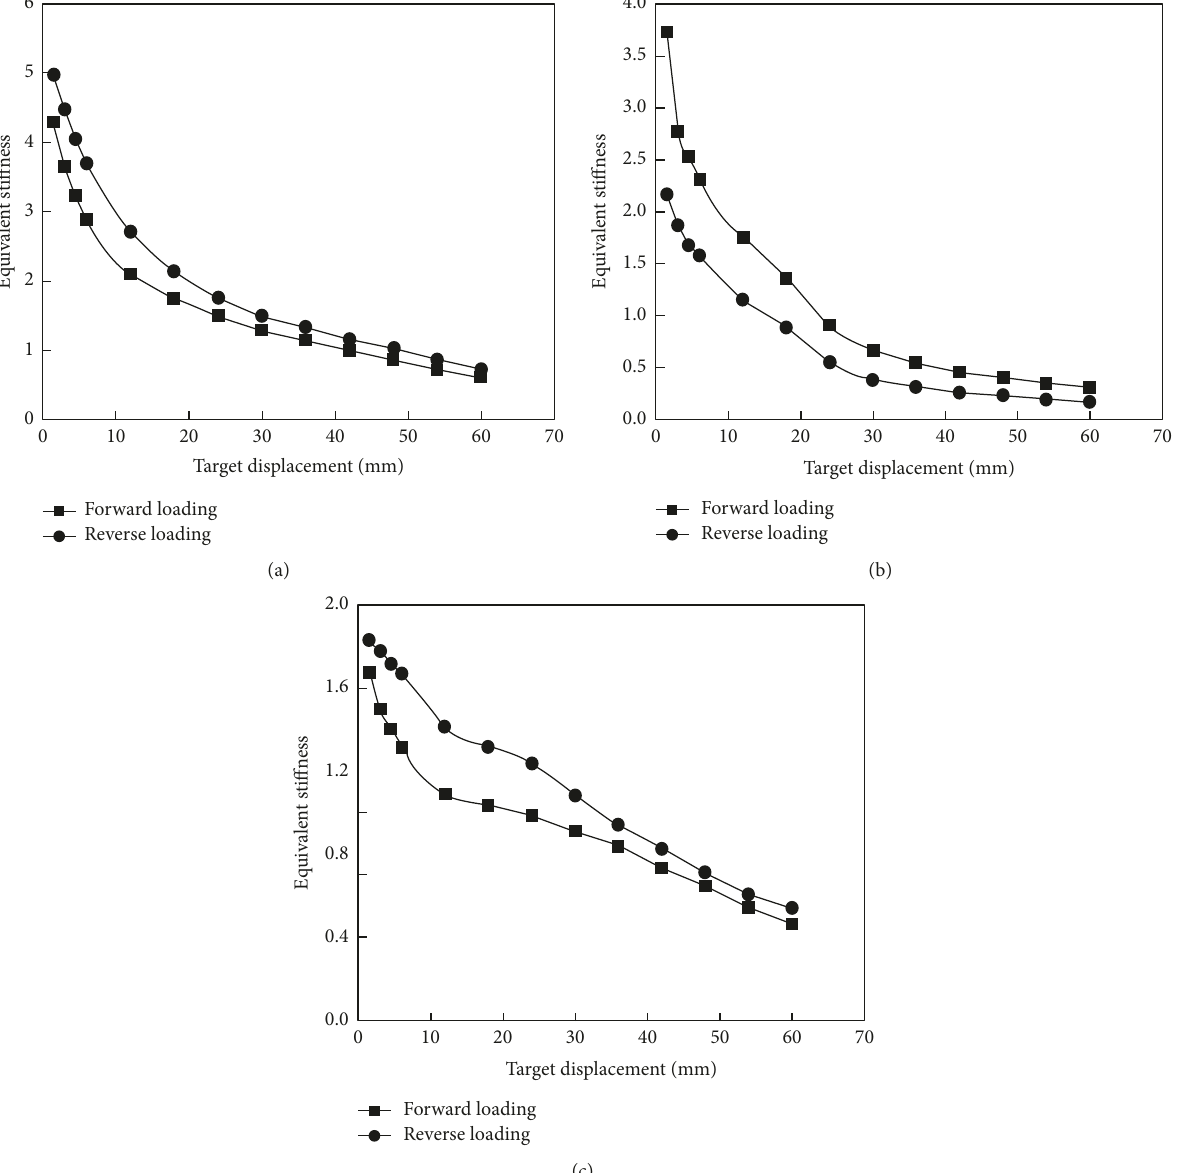
Figure 9: Degeneration rigidity loops of specimens. (a) Specimen DWHP-1, (b) specimen DWHP-2, and (c) specimen